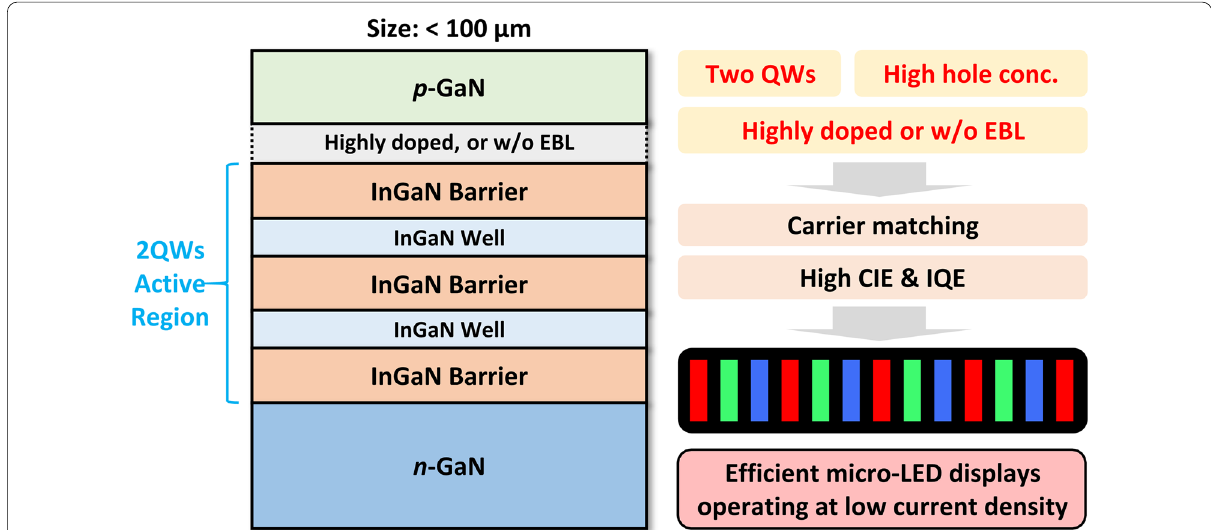
Fig. 9 Schematic illustration of the optimized epitaxial structure designed specifically for the micro-LED emissive displays operating at low current intrinsic Fermi level, c p and c n are the capture coefficients for electron and hole, N t is the trap density, σ p and σ n are capture cross sections for electron and hole, and ν p and ν n are the average thermal velocities of electron and hole, respectively. According to Eqs. (8)-(10), the SRH recom- bination of a trap is completely specified by its density, capture cross sections and energy level.